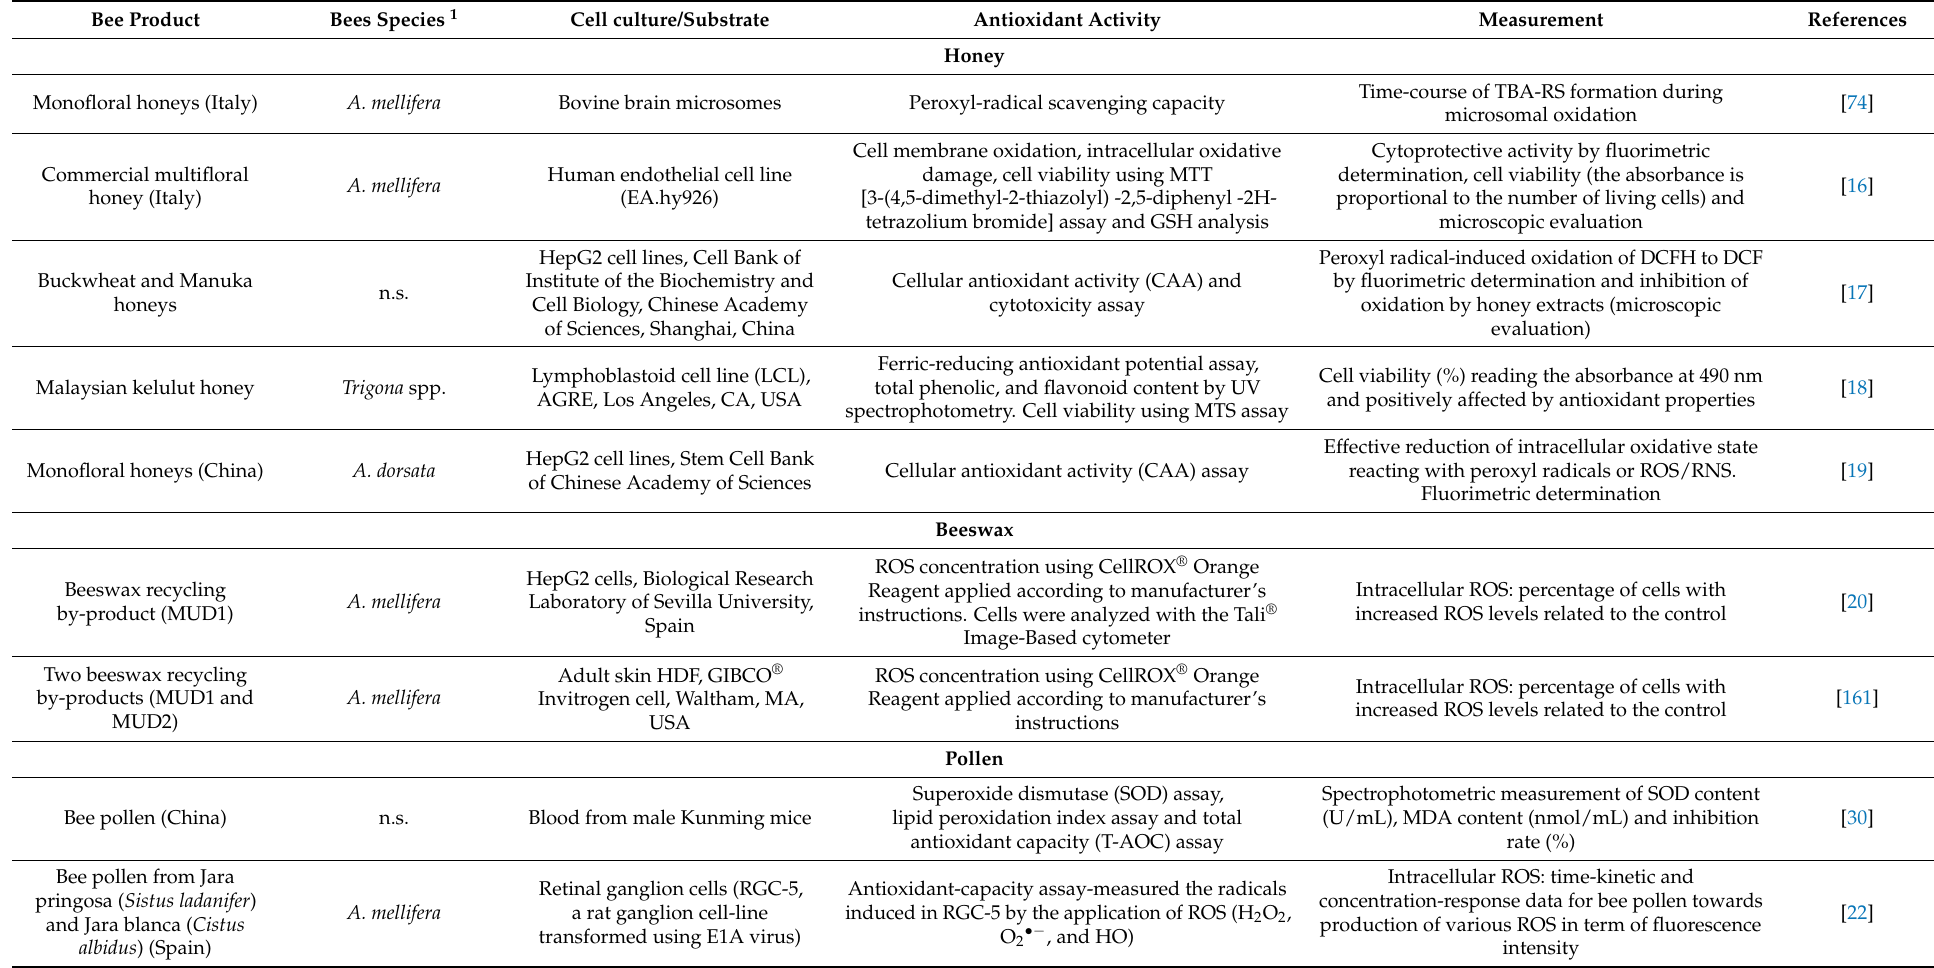
Table 6. In vitro antioxidant properties of bee